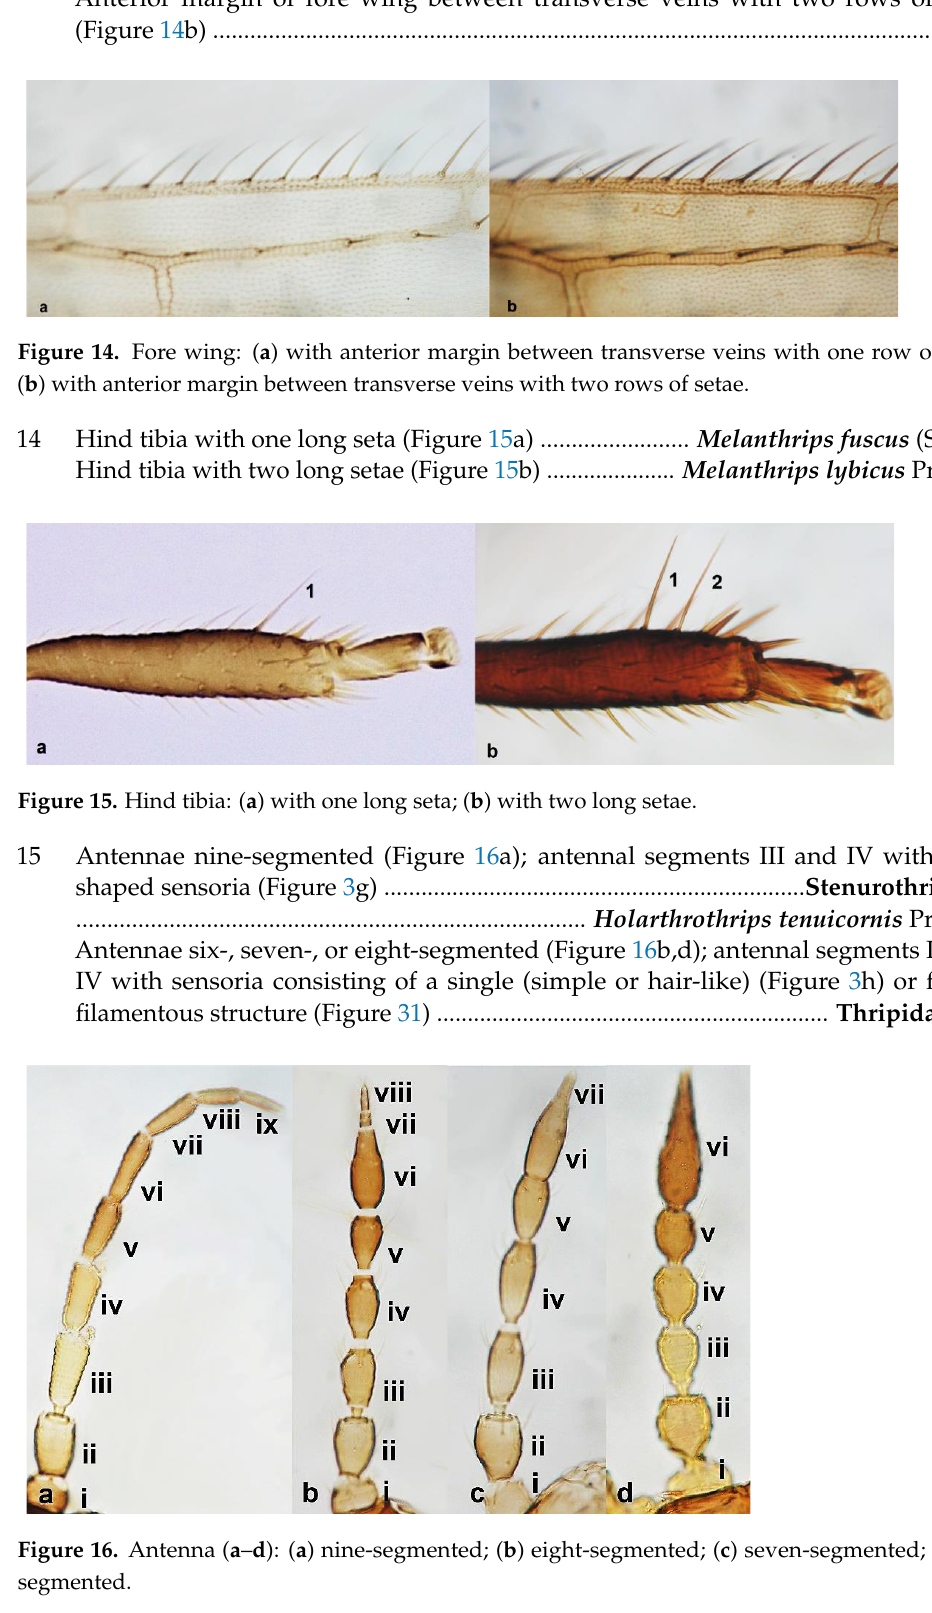
13 Anterior margin of fore wing between transverse veins with one row of setae (Figure 14a) ........................................................................ Melanthrips knechteli Priesner Anterior margin of fore wing between transverse veins with two rows of setae (Figure 14b) .......................................................................................................................... 14